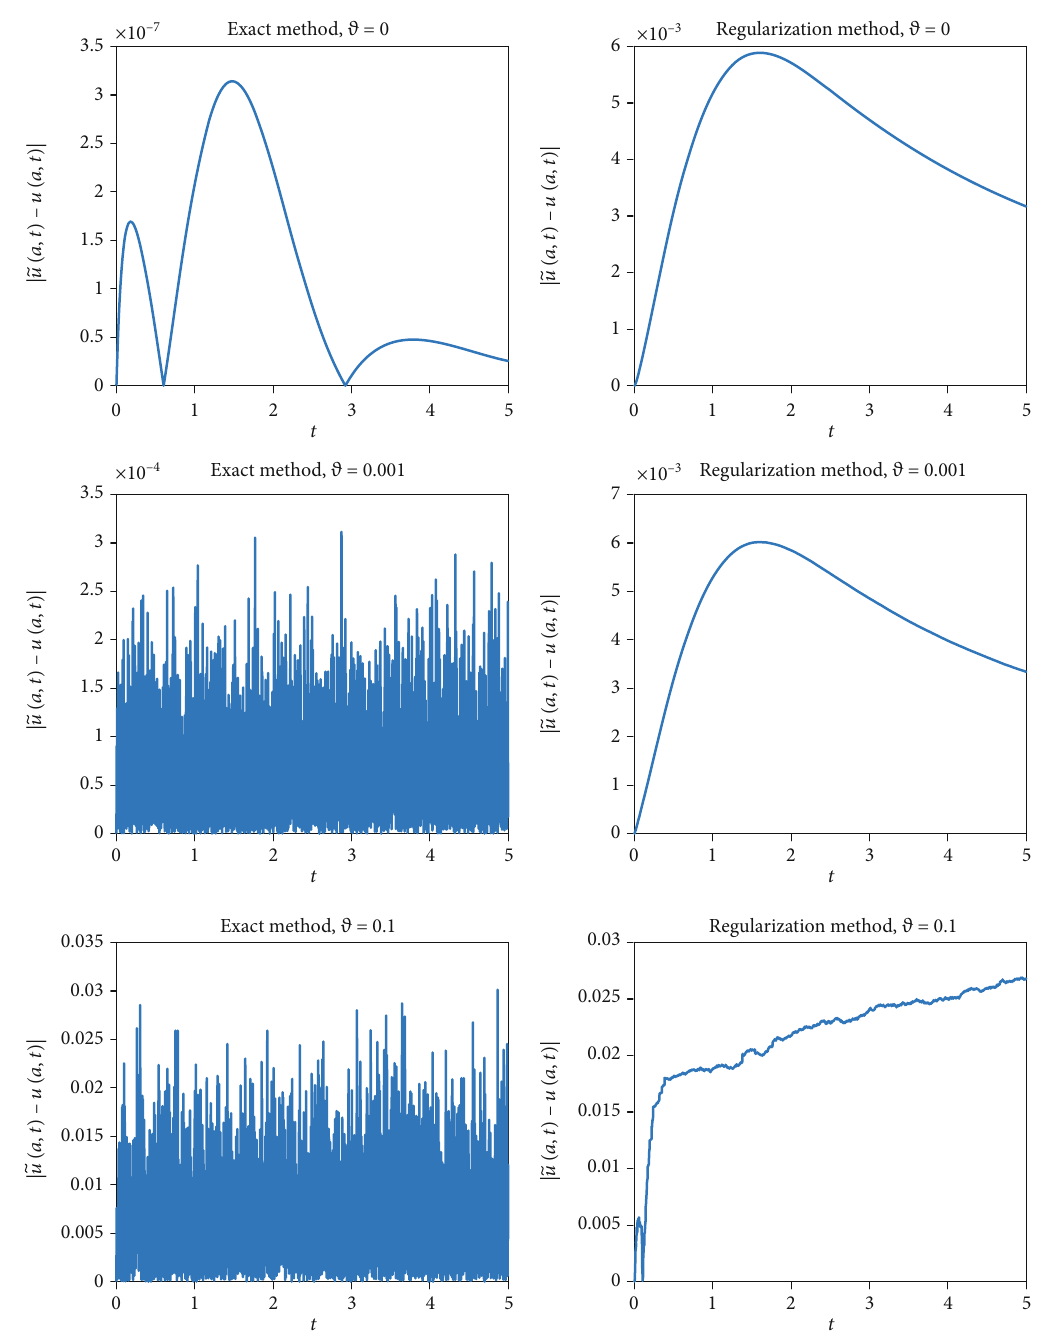
Figure 4: The absolute errors j ~ u ð a , t Þ − u ð a , t Þj , with the exact and regularization methods and di ff erent values of noises for Example 2 using Δ t = 0 : 001 and h = 0 : 05